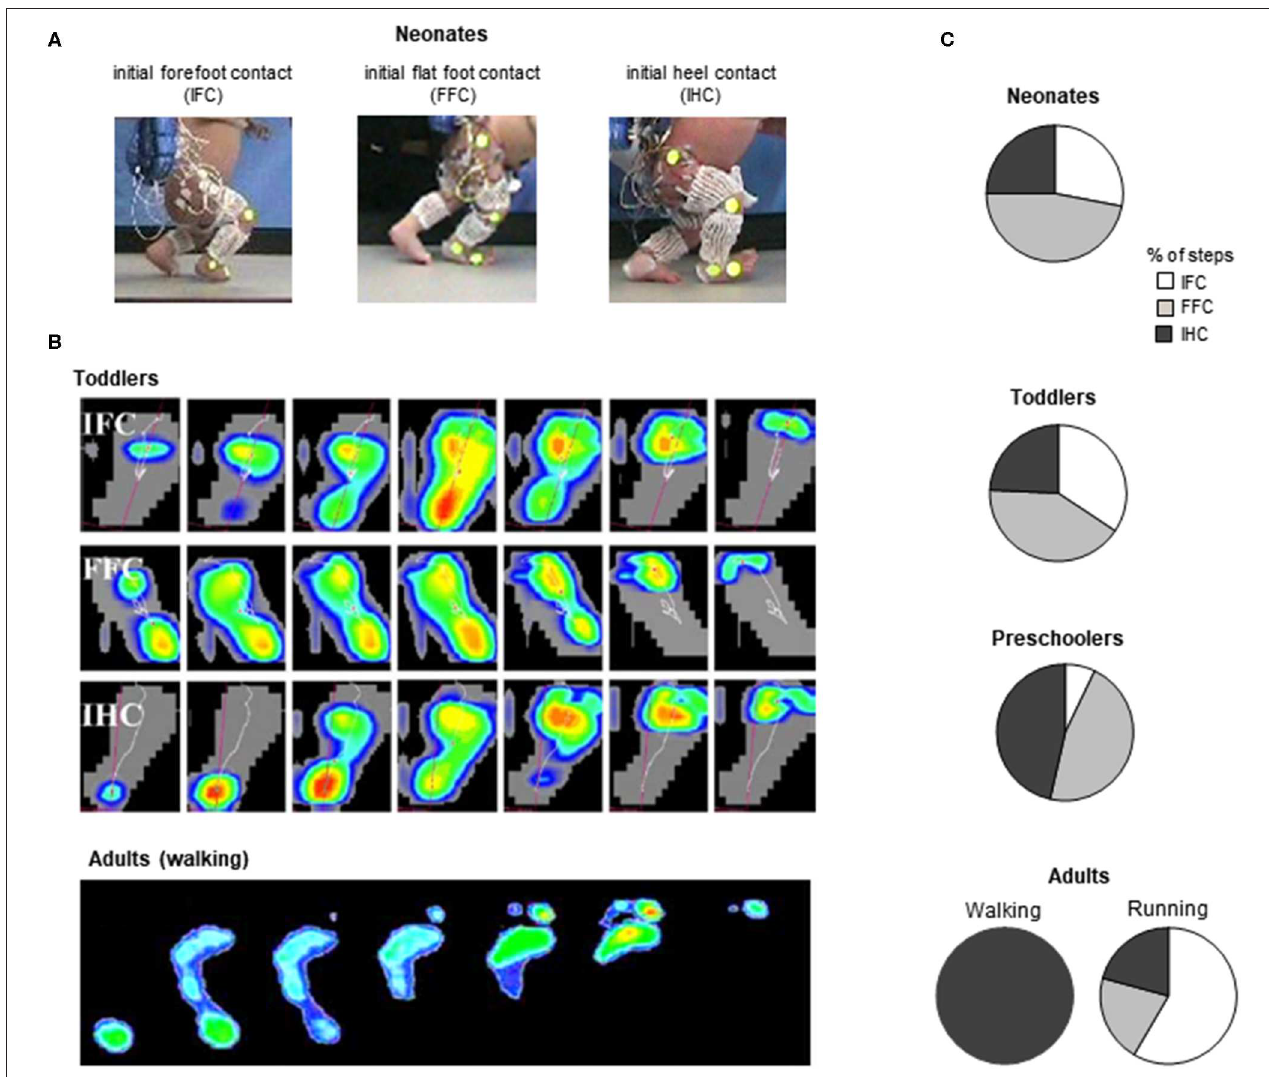
FIGURE 4 | General foot placement characteristics during stepping. (A) examples of initial forefoot (IFC), flat foot (FFC), and heel (IHC) contacts in three neonates (adapted from Sylos-Labini et al., 2017). (B) from top to bottom: three different foot-contact patterns in toddlers (IFC, FFC, and IHC) and plantar pressure prints (left foot) of a typical adult “heel-to-toe” rolling pattern during the stance phase (redrawn from Hallemans et al., 2006b with permission from Elsevier). (C) percent of steps with different types of touchdown contacts for stepping in neonates (from Sylos-Labini et al., 2017), toddlers and preschoolers (from Hallemans et al., 2006b) and adult walking and running (from Larson,